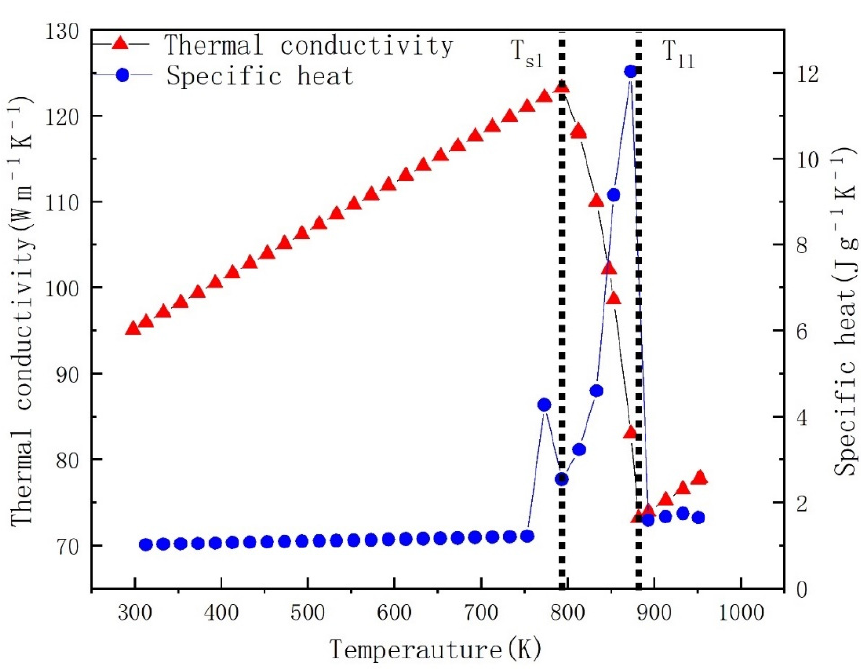
Figure 4. The variations of thermal conductivity and specific heat with temperature.